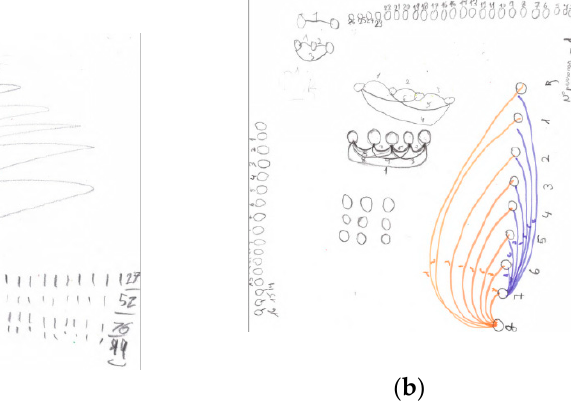
Figure 8. Counting strategies. Drawing made by participant: ( a ) A6; ( b ) A1.